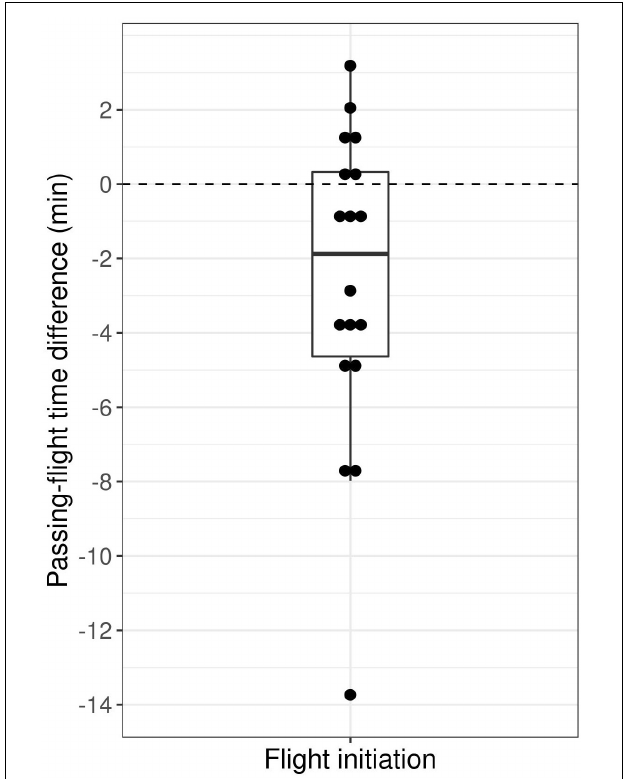
FIGURE 1 | Time difference between the start of the wolf’s flight and the observer passing the passing position (PP) of wolves during experimental approach trials by humans in south-central Scandinavia, 2018–2021 ( N = 18), where a negative time difference indicates a flight started before the observer passed the